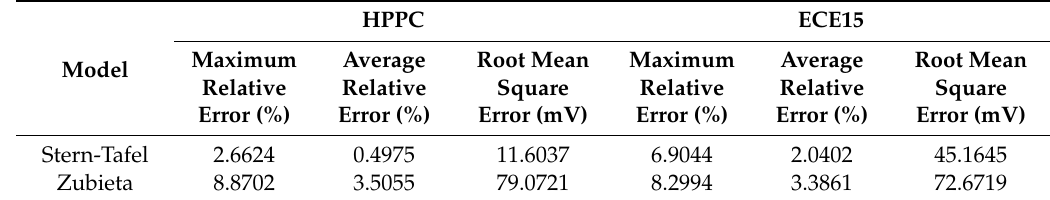
Table 4. The statistical metric with Current Profile i 1 .